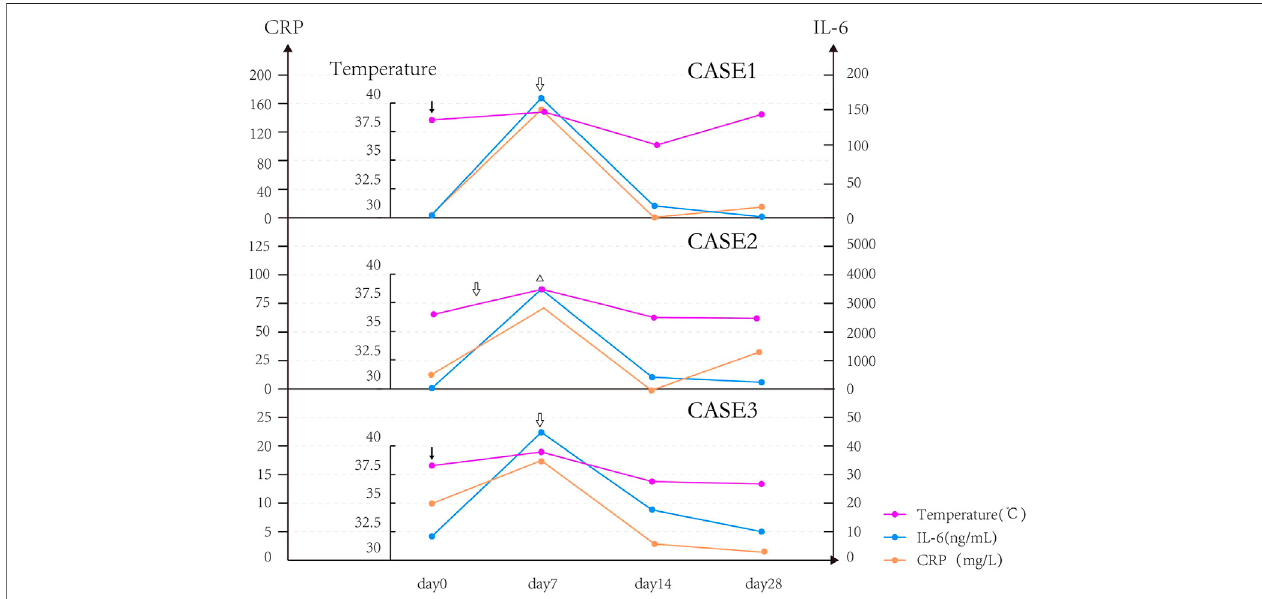
FIGURE 2 | Changes in temperature and IL-6 after transfusion of CAR T-cells in patients with CRS.